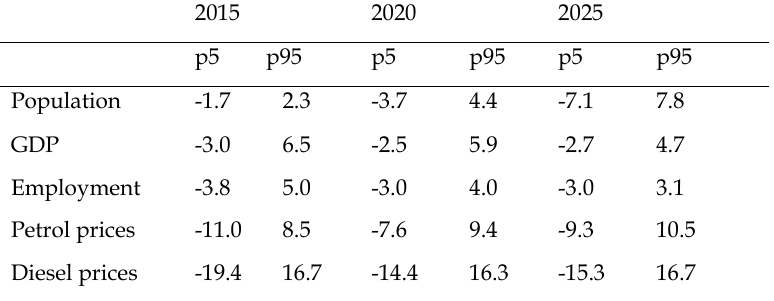
p5 and p95 NTM socio-economic variable annual growth rates used to run the sensitivity